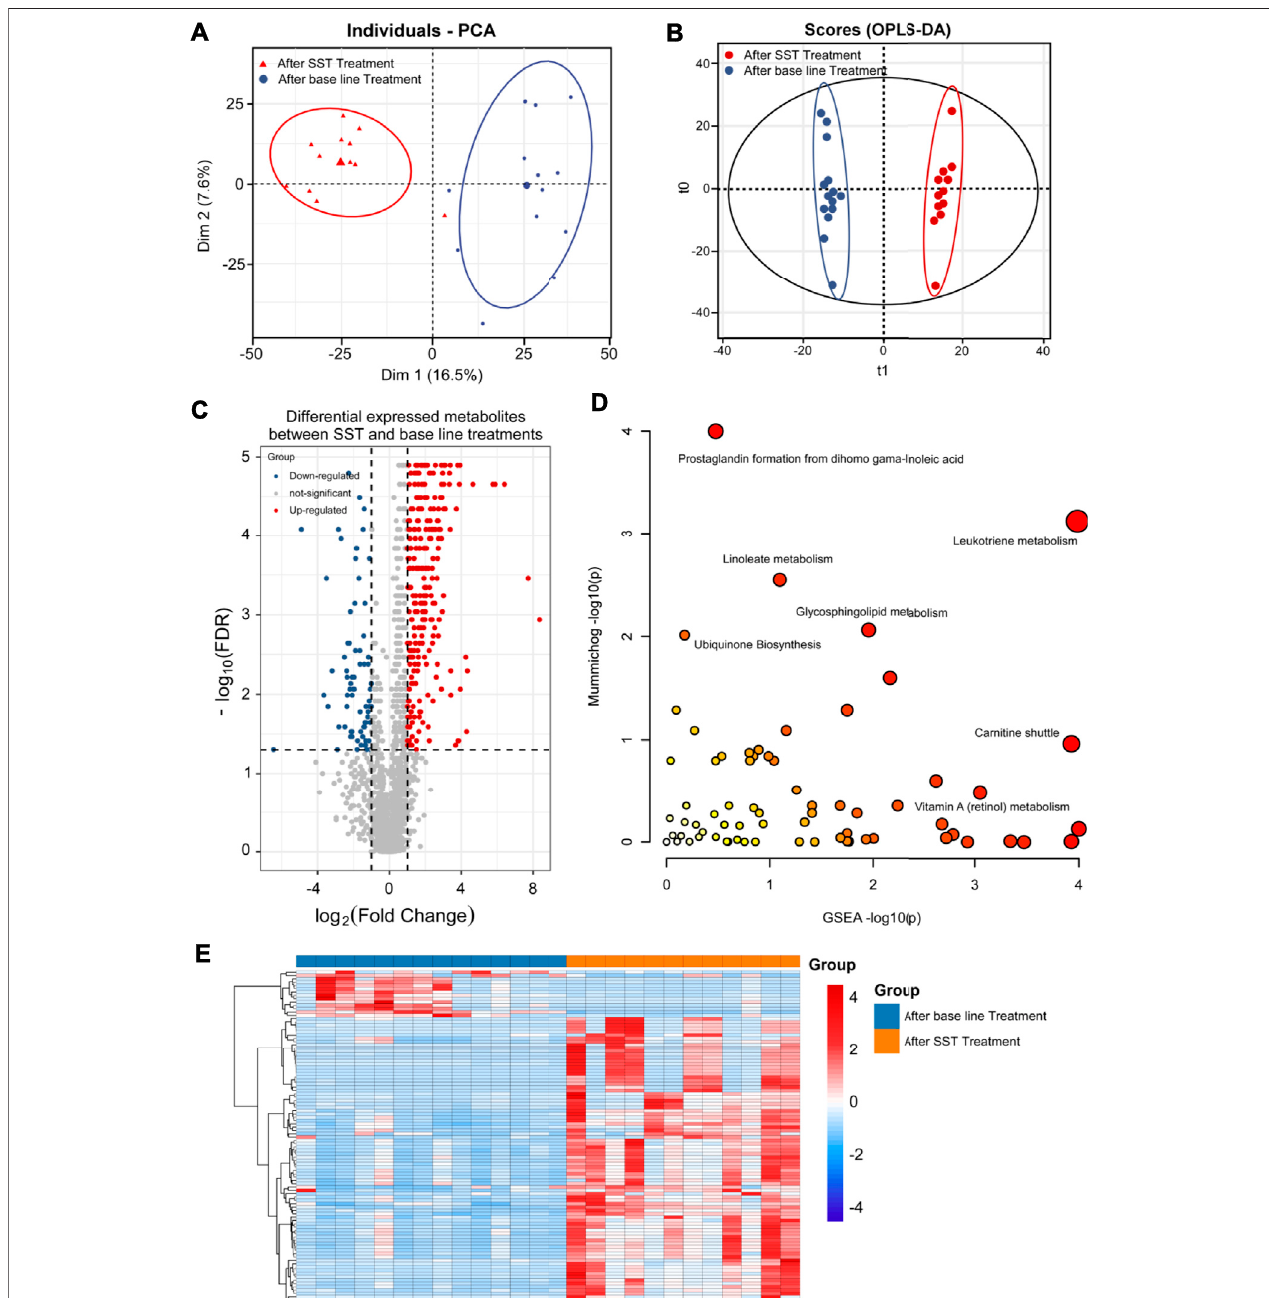
FIGURE3| Metabolomicsanalysisofbreastcancerpatients ’ serumsafterSSTtreatment. (A,B) PCA (A) andOPLS-DA (B) plotsofthemetabolitesdetectedinserums of breast cancer patients before and after SST treatment (n (cid:1) 12). (C) Volcano plot showing the DEMs identi fi ed in serums of breast cancer patients after SST treatment. (D) The bubble plot showing the enriched pathways of DEMs identi fi ed in serums of breast cancer patients after SST treatment. (E) The heatmap illustrating the levels of DEMs identi fi ed in serums of breast cancer patients after SST treatment; each row represents one metabolite, and each column represents one sample.